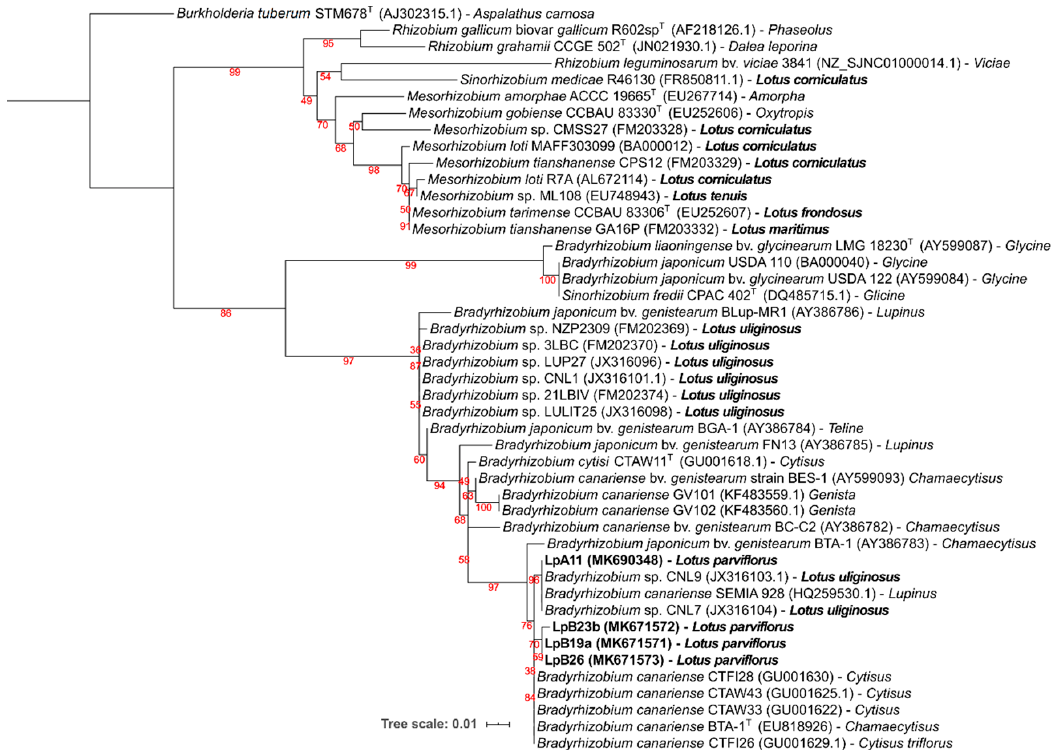
Figure 5. Phylogenetic tree of nifH gene sequences. Analyses were conducted with IQ-tree using Maximum Likelihood (ML) and ModelFinder (Best model: K2P + G4) methods), for a total of 203 positions. Bootstrap values are shown at each node. NCBI Genebank accession codes and original legume host of isolation are indicated. Burkholderia tuberum STM678 T (AJ302315.1), a bacterium from the beta-proteobacteria class that nodulates Aspalathus carnosa , was selected as an outgroup. Lotus spp. and isolates obtained from L. parviflorus nodules are in bold. Table 3. Host range assays performed in different legume host plants inoculated with the different bacterial isolates .